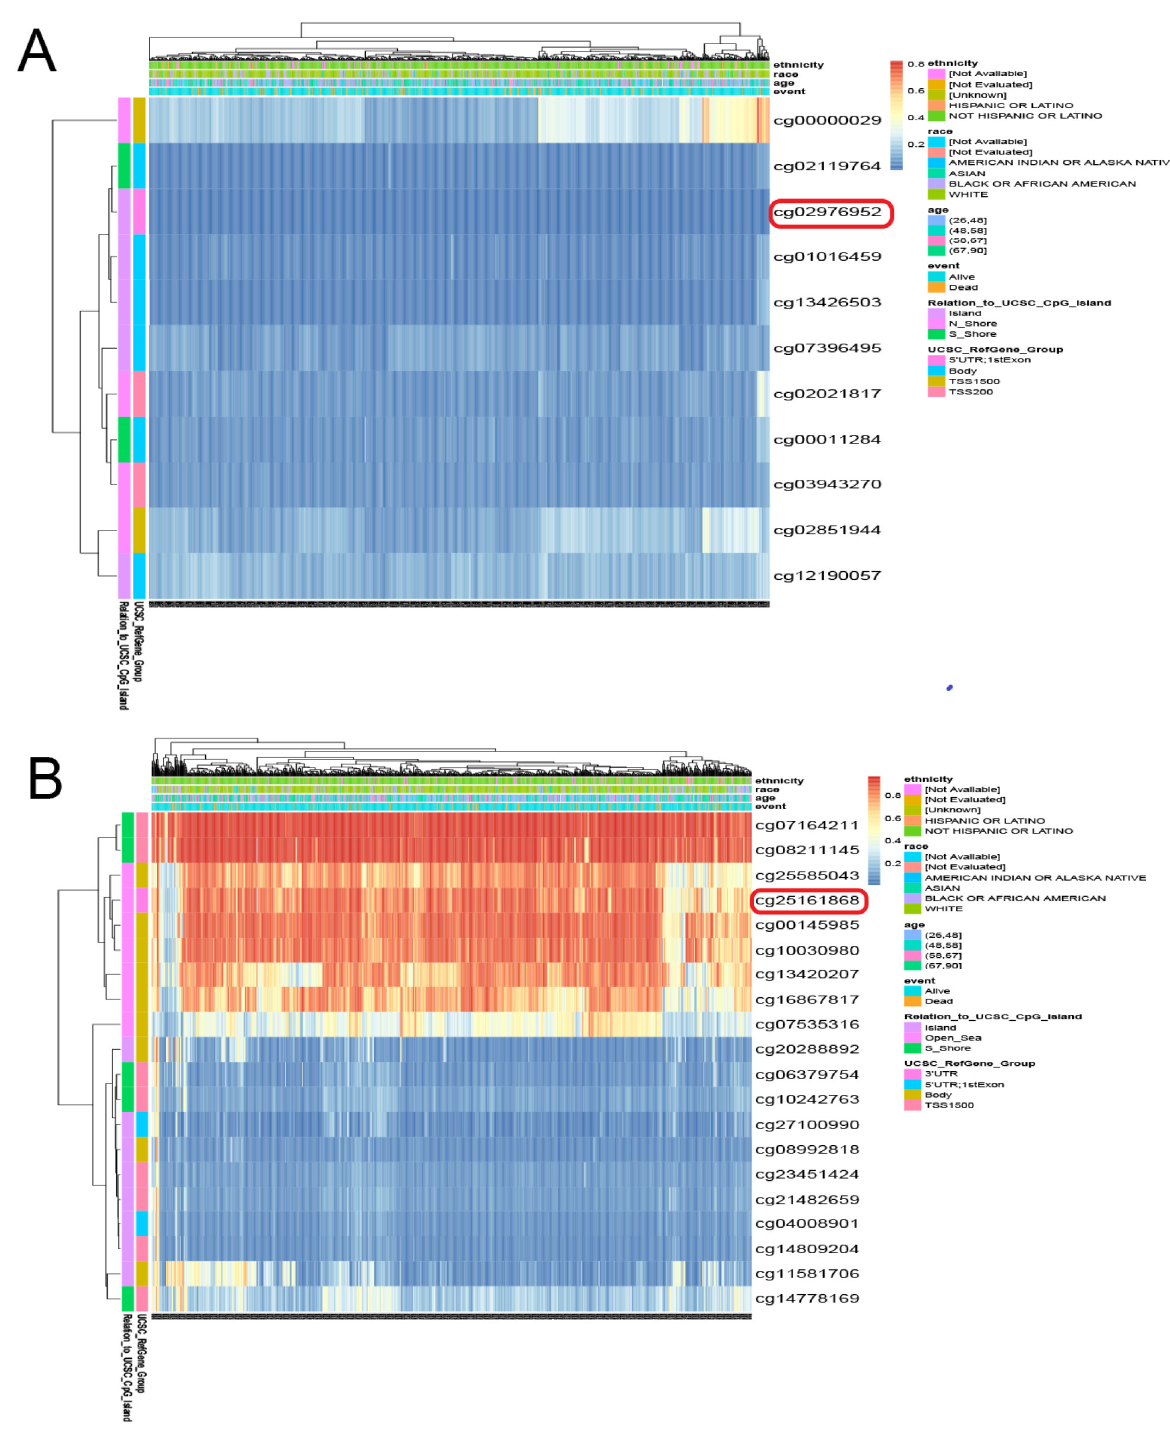
Figure 9. Heatmaps of different methylated regions associated with PRLR ( A ) and CACNA2D1 ( B ) generated by MethSurv.